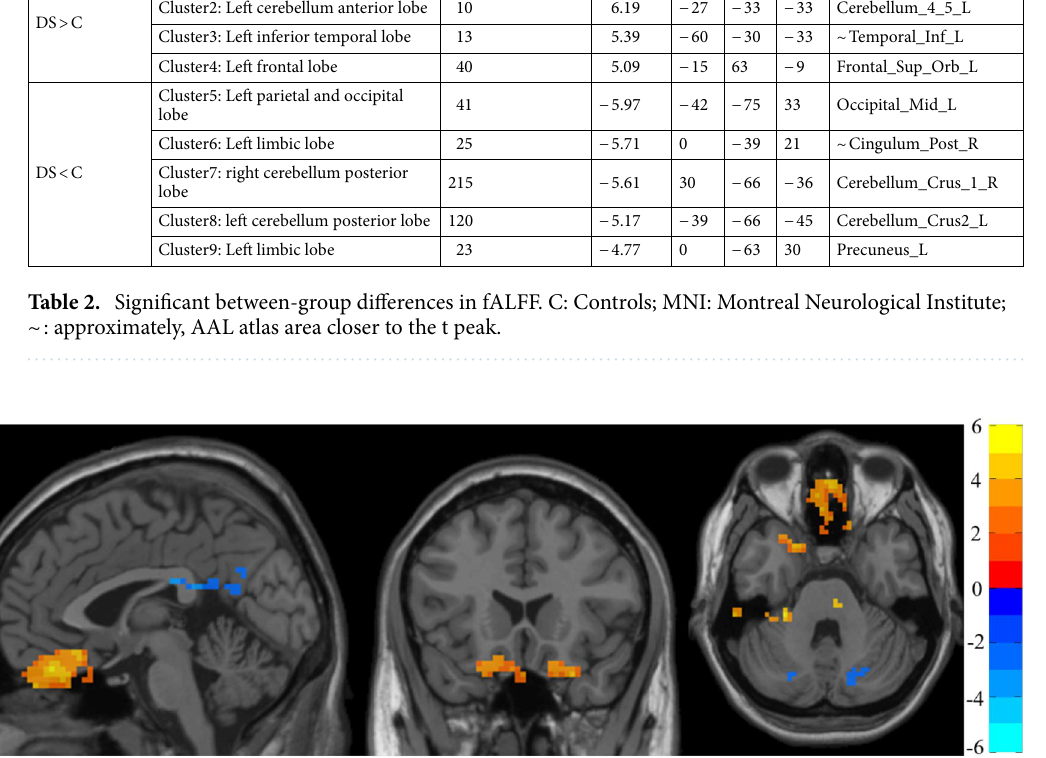
Figure 1. fALFF analysis. Two-sample t test results are presented, corrected by a permutation test with TFCE, p < 0.05. The area in blue represents a significantly decreased ALFF value in DS patients compared with controls; the area in yellow and red represents a significantly increased fALFF value in DS patients compared with